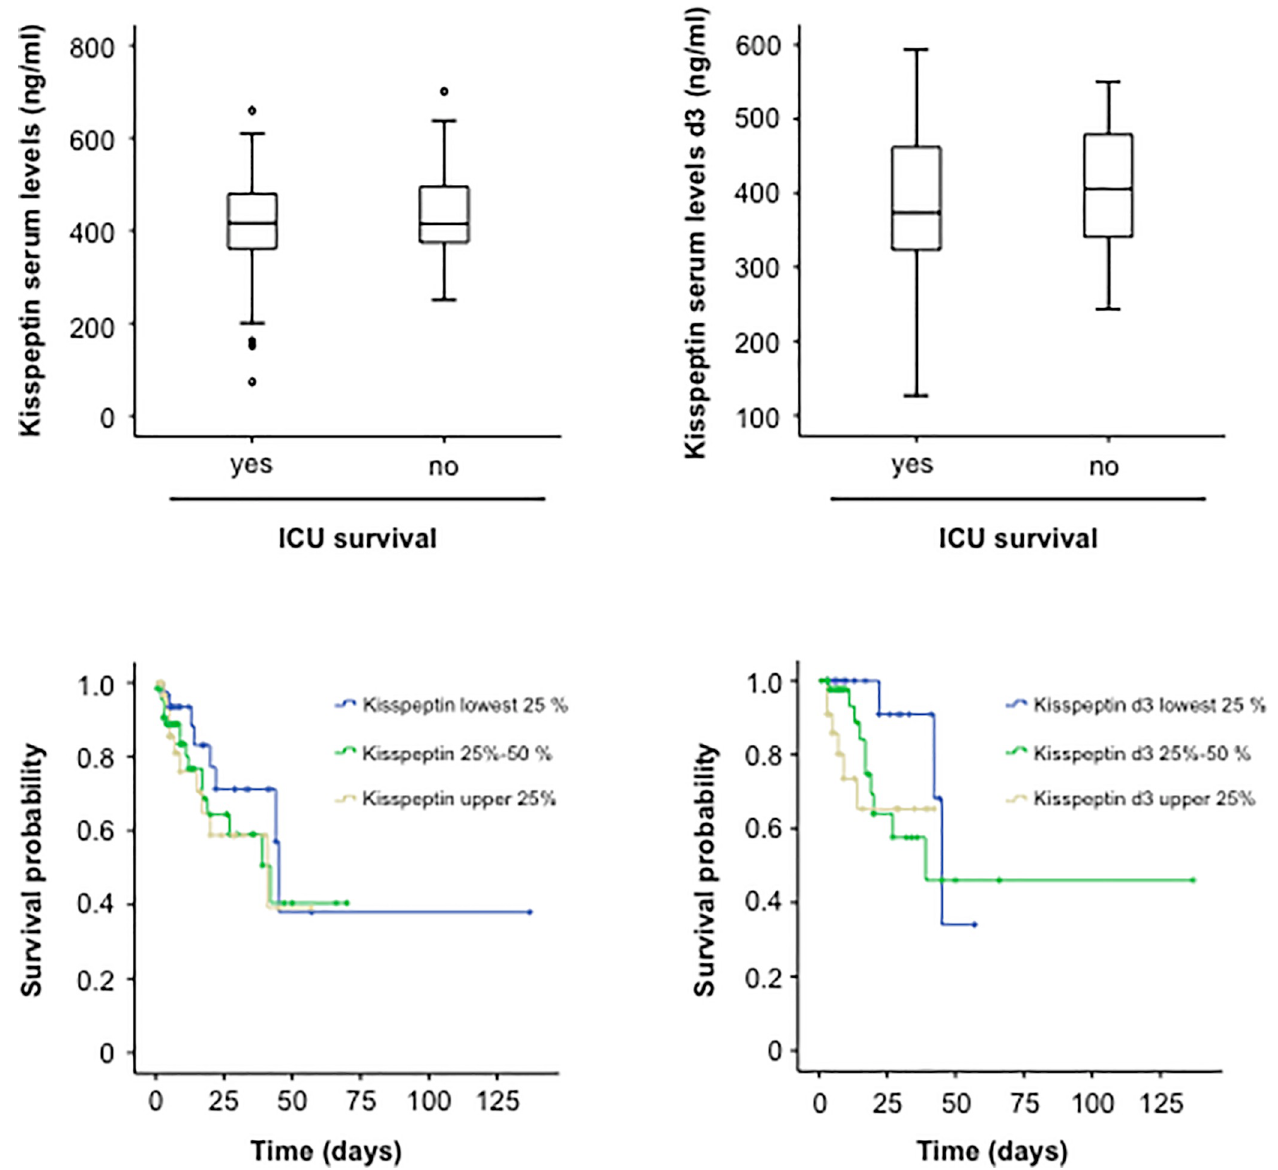
Fig 4. Elevated kisspeptin concentrations do not reflect ICU-survival. (a) Serum levels of kisspeptin at admission to the ICU were similar in patients that survived ICU treatment and patients that succumbed to death during ICU treatment. (b) Serum levels of kisspeptin after three days of ICU-treatment were similar in patients that survived ICU treatment and patients that succumbed to death during ICU treatment. (c) Kaplan-Meier curve analysis revealing that serum levels of kisspeptin at admission to the ICU did not reflect patients ICU survival. (d) Kaplan-Meier curve analysis revealing that serum levels of Kisspeptin after three days of ICU treatment did not reflect patients ICU